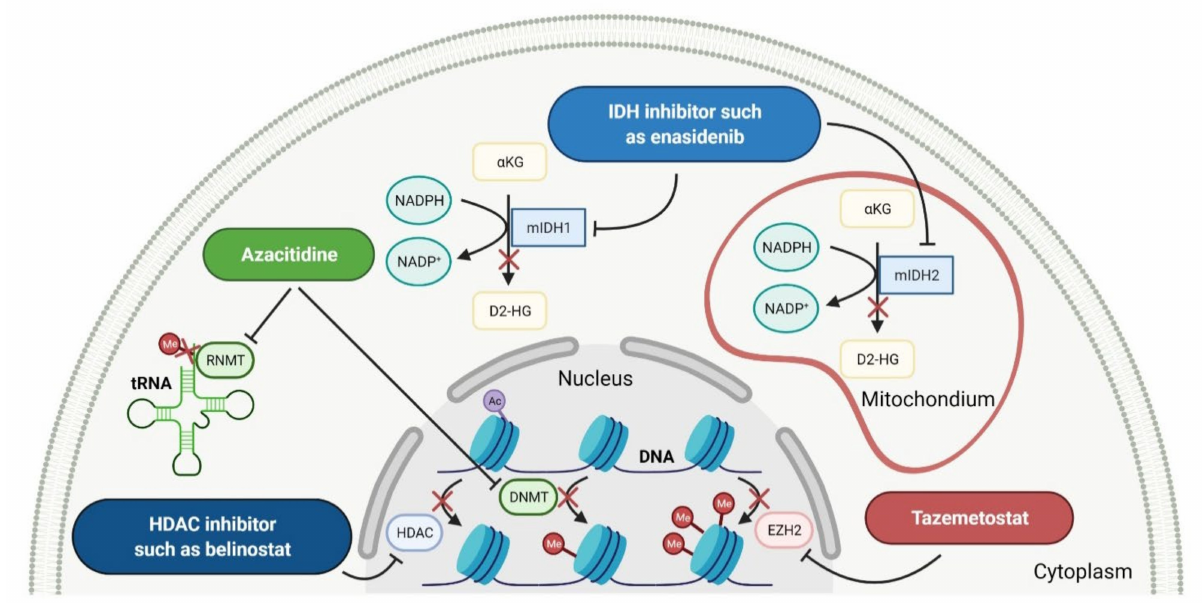
Figure 4. Mode of action of various enzymes inhibitors. HDAC : histone deacetylase. RNMT : RNA methyltransferase. DNMT : DNA methyltransferase. EZH2 : enhancer of zeste homolog 2. mIDH1 : mutant isocitrate dehydrogenase 1. mIDH2 : mutant isocitrate dehydrogenase 2. NADPH : nicotinamide-adenine dinucleotide phosphate (reduced form). NADP + : nicotinamide-adenine din- ucleotide phosphate. α KG : α -ketoglutarate. D2-HG : D-2-hydroxyglutarate. Me : methyl group. Ac : acetyl group. DNA : deoxyribonucleic acid. tRNA : transfer ribonucleic acid. Created with